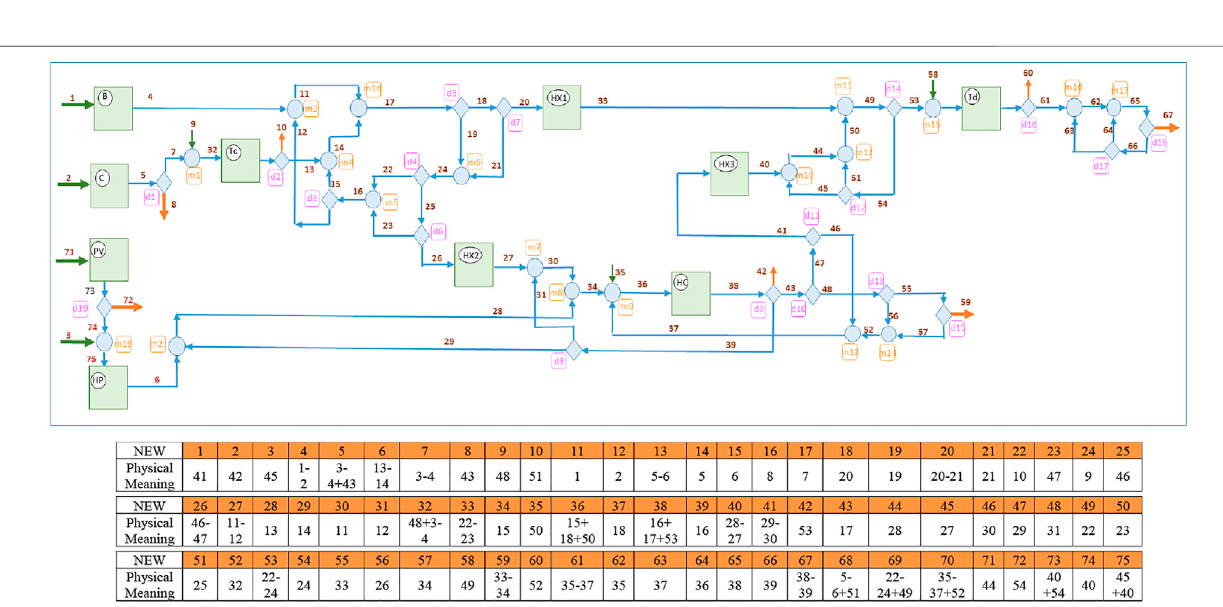
Frontiers in Energy Research |